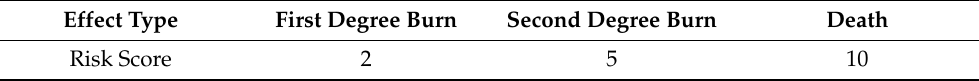
Table 5. Risk score chart [19].